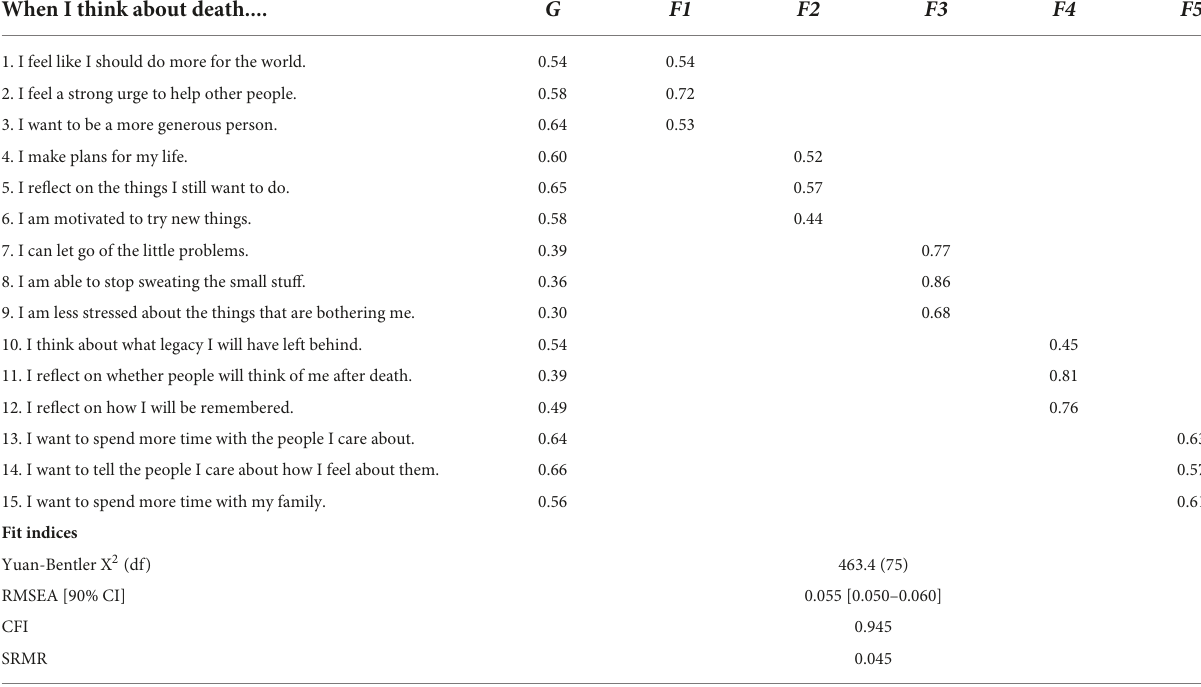
TABLE 5 Confirmatory factor analysis for a higher-order factor solution for the total sample. When I think about death....